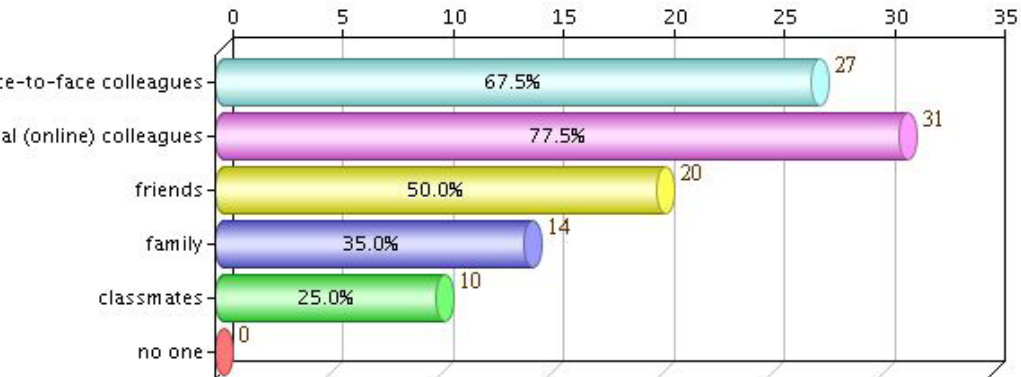
Figure 11 . With whom outside of the MobiMOOC did you share what you have learned in the MobiMOOC? ( N =